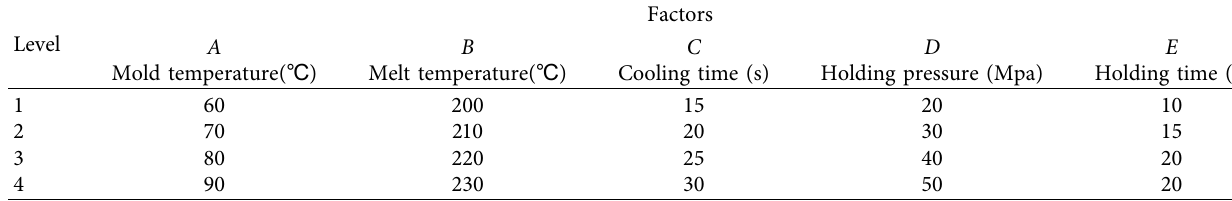
Table 3: Table of horizontal factor settings.